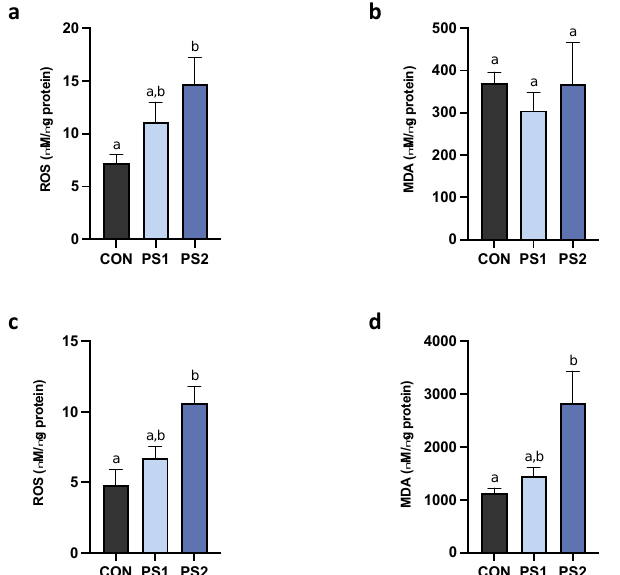
Figure 3. The oxidative stress induced by PS-MPs in the gut of gilthead seabreams. ( a , c ) ROS and ( b , d ) MDA levels were measured in the anterior (AI) and posterior intestine (PI), respectively. All data are shown as mean ± S.E.M. Different letters indicate significant differences among treatments (at least p < 0.05).